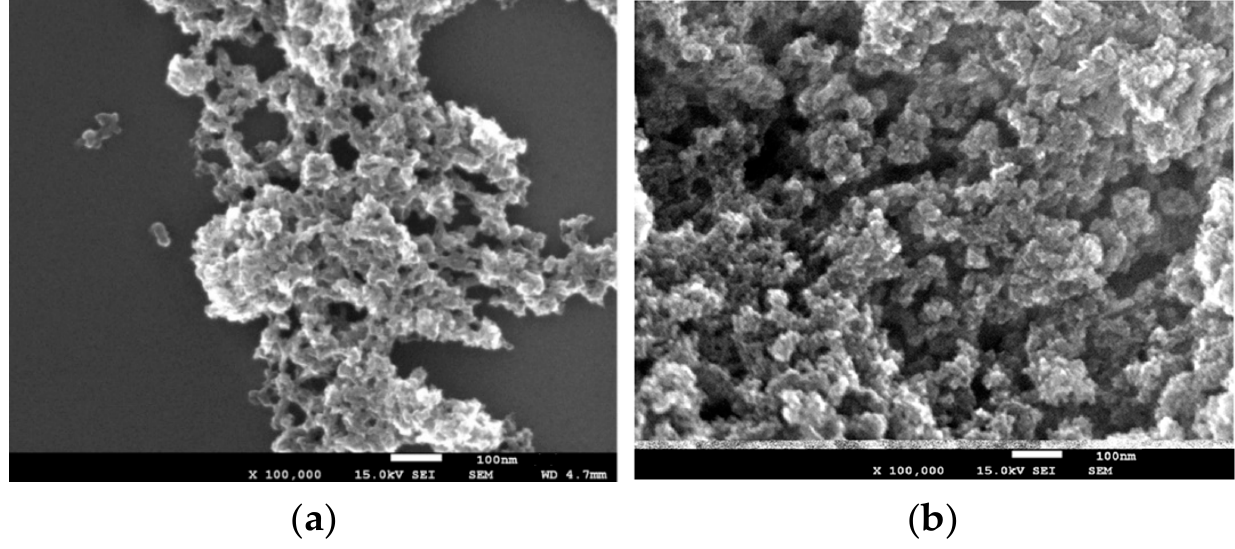
Figure 5. SEM microphotographs of ( a ) bare hydrated TiO 2 and ( b ) Mn(TMPIP)/TiO 2 .